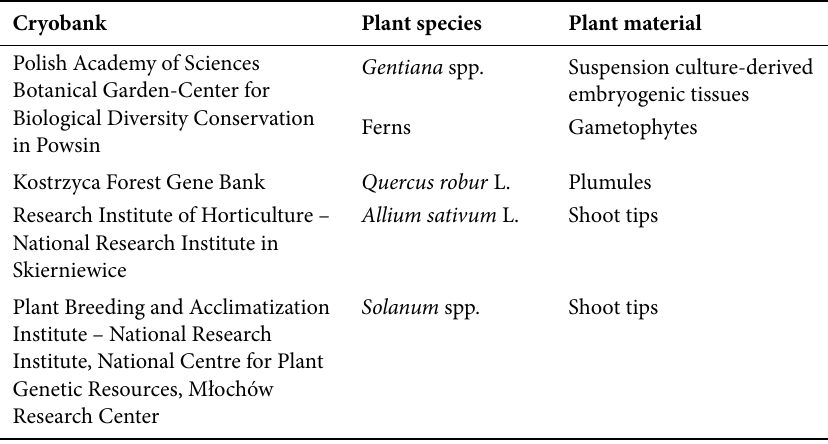
Table 1 In vitro culture-derived plant material stored in Polish